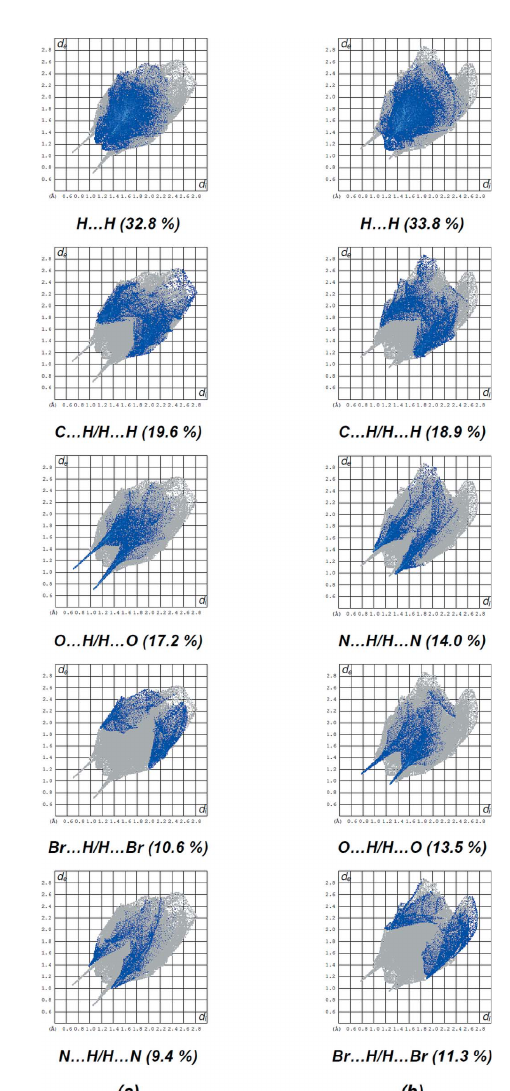
Figure 9 The two-dimensional fingerprint plots [( a ) for molecule A and ( b ) for molecule B ], showing all interactions and those delineated into H (cid:2)(cid:2)(cid:2) H, C (cid:2)(cid:2)(cid:2) H/H (cid:2)(cid:2)(cid:2) C, O (cid:2)(cid:2)(cid:2) H/H (cid:2)(cid:2)(cid:2) O, Br (cid:2)(cid:2)(cid:2) H/H (cid:2)(cid:2)(cid:2) Br, N (cid:2)(cid:2)(cid:2) H/H (cid:2)(cid:2)(cid:2) N interactions. The d i and d e values are the closest internal and external distances (in A˚ ) from given points on the Hirshfeld